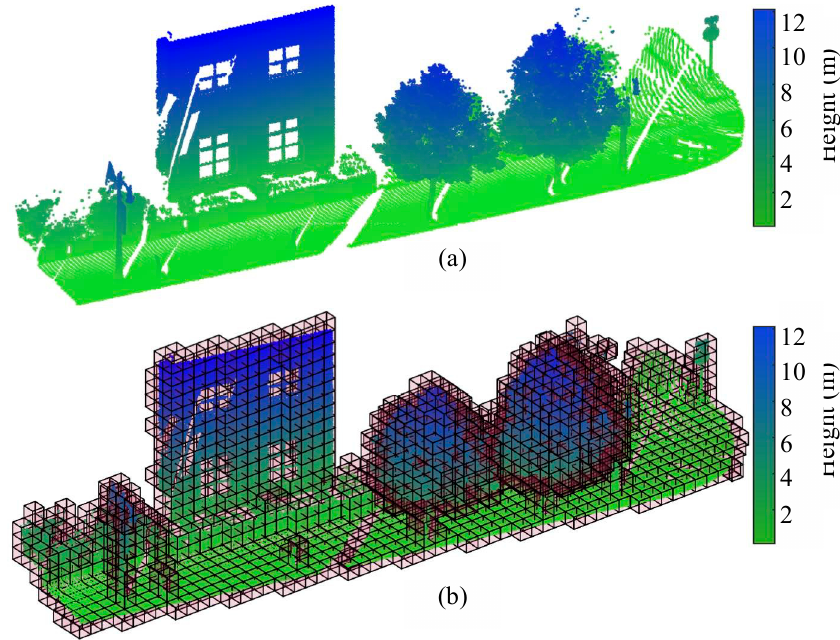
Figure 5. Point cloud voxelization. ( a ) Original dataset; ( b ) Regular voxels.